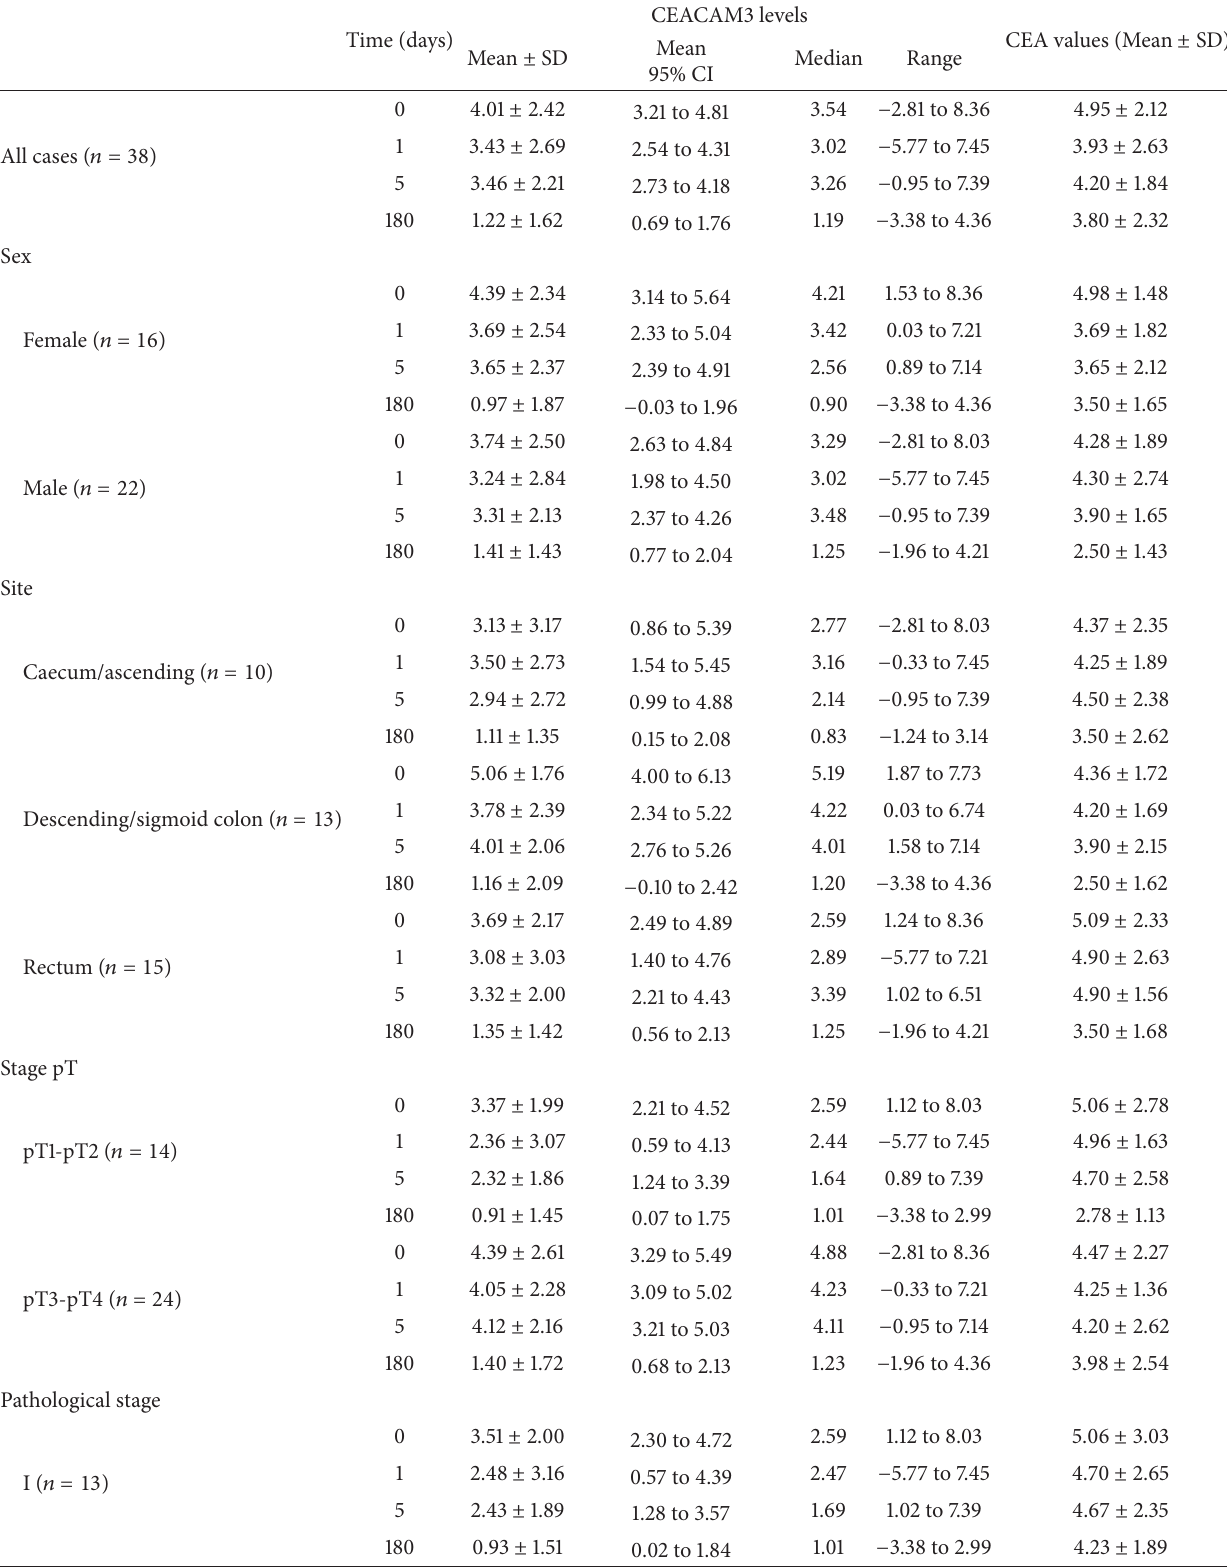
Table 1: Clinical/pathological characteristics of patients and associated CEACAM3